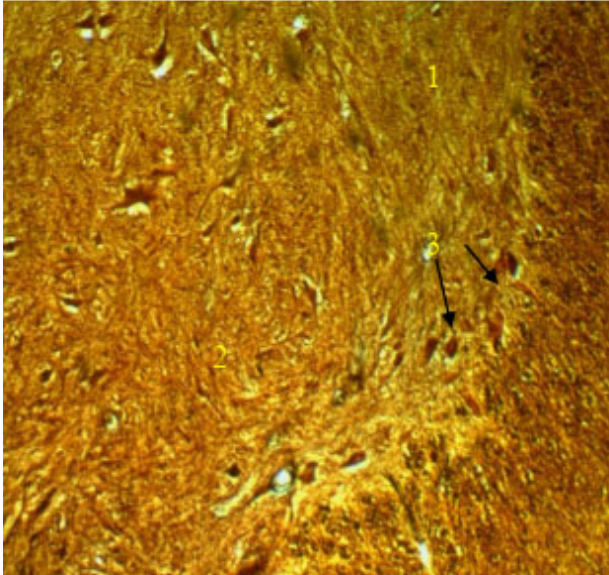
Fig. 4. Fragment of the microscopic structure of the gray matter of the spinal cord of mature cattle: 1 – nerve cell; 2 – the nucleus of the nerve cell; 3 – nucleolus; 4 – nerve cell process; 5 – basophilic granularity; 6 – neuroglia cells. Nissl. ×